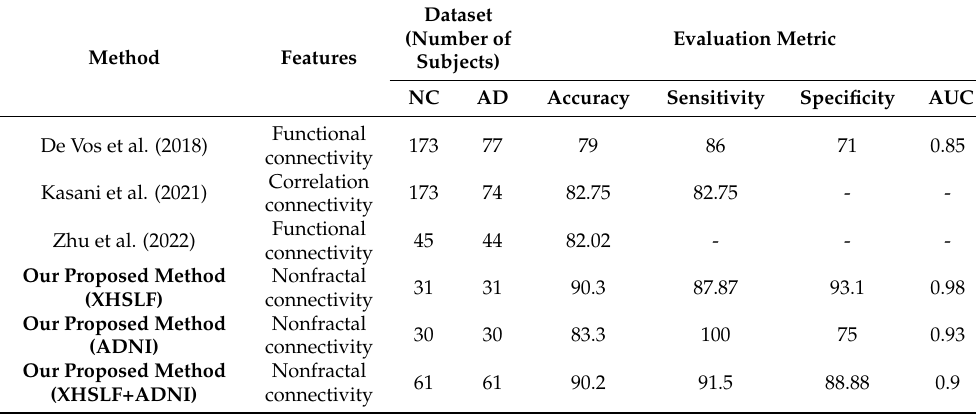
Table 8. Comparison with previous studies in terms of accuracy (%), sensitivity (%), specificity (%) and